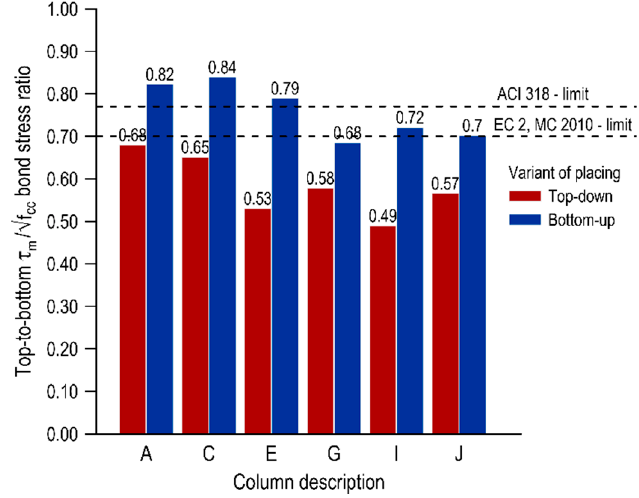
Figure 7. Top-to-bottom ratio for normalized mean bond stresses.